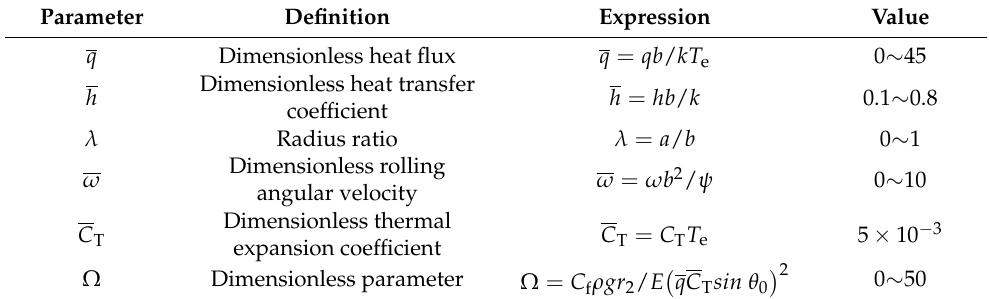
Table 2. Dimensionless